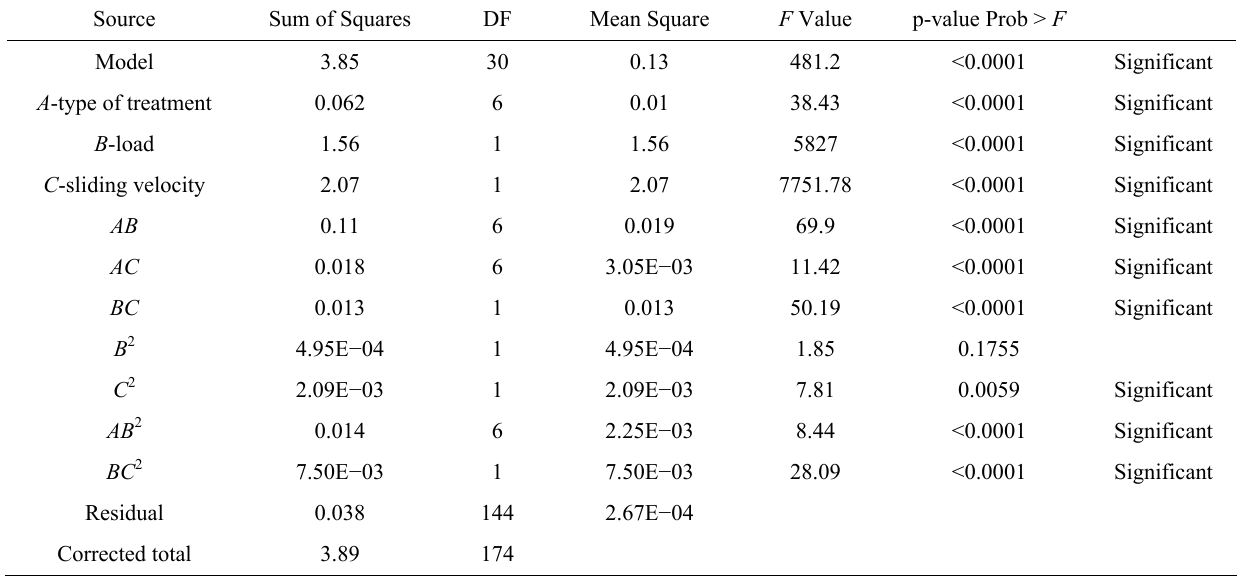
Table 12 Modified ANOVA for maximum contact temperature.